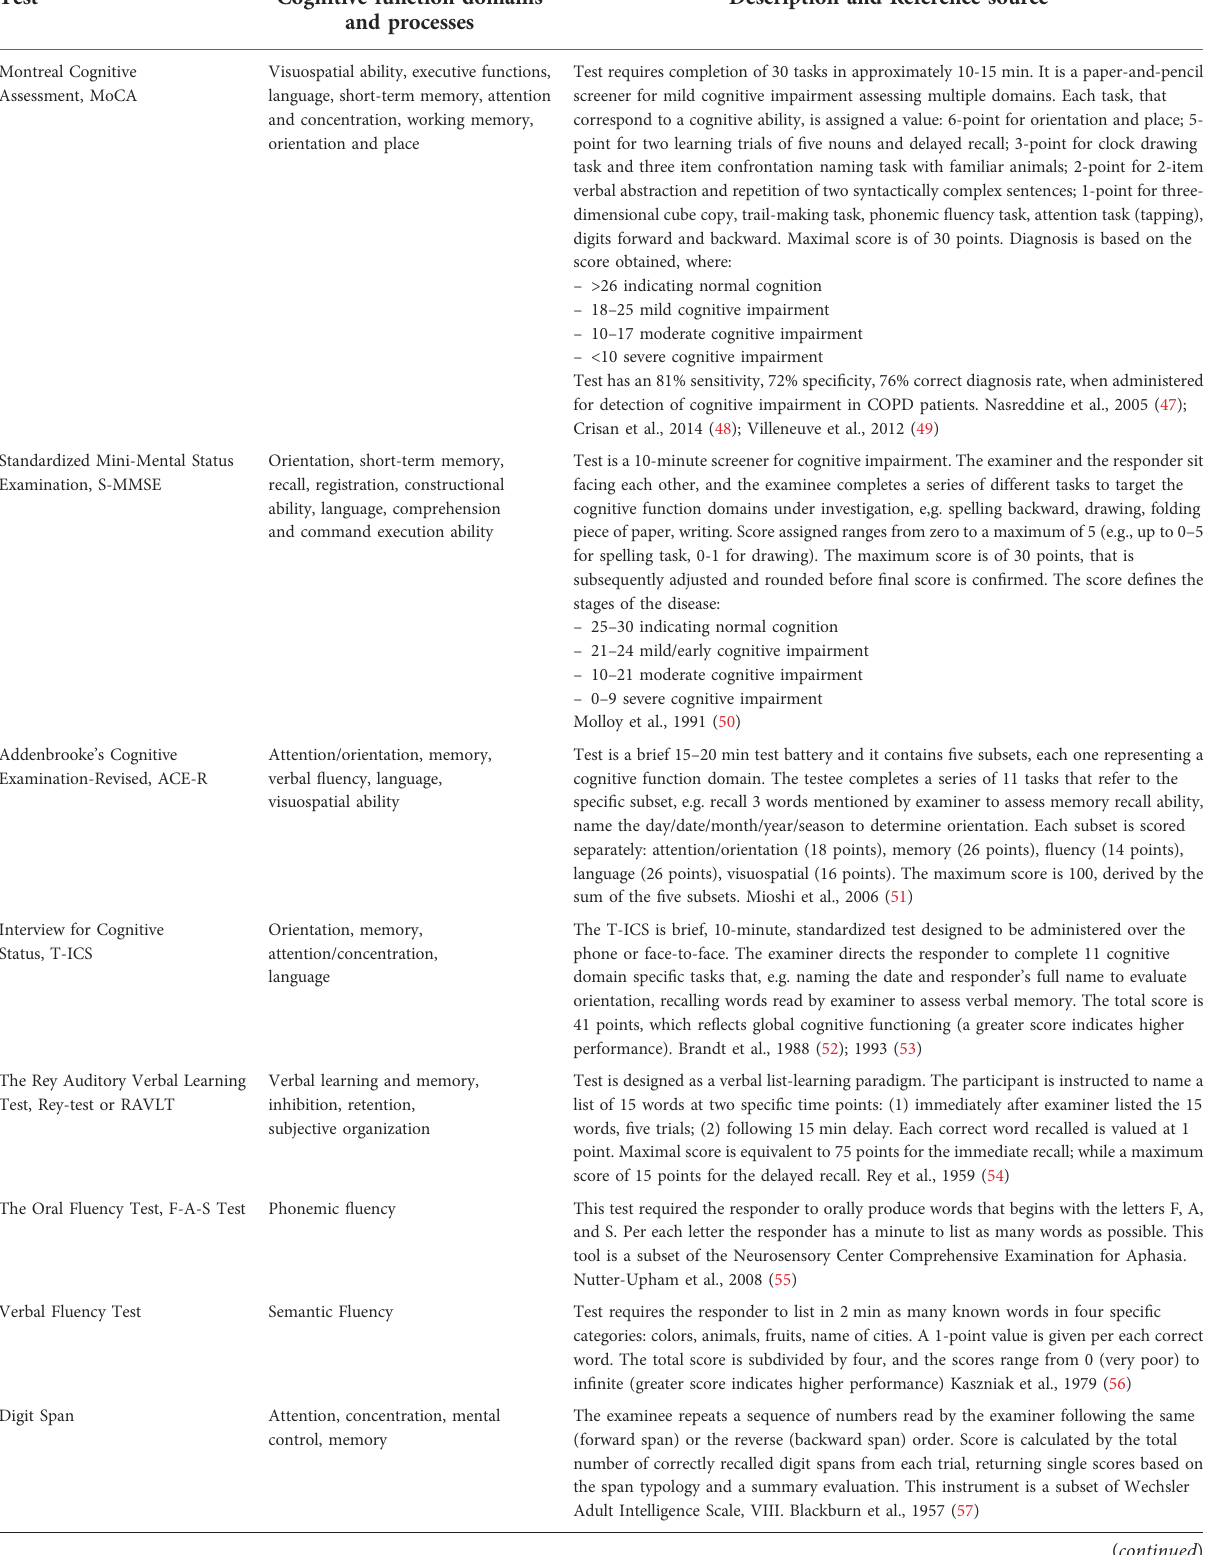
TABLE 2 List of the neurocognitive tests administered in the fi ve studies allocated to